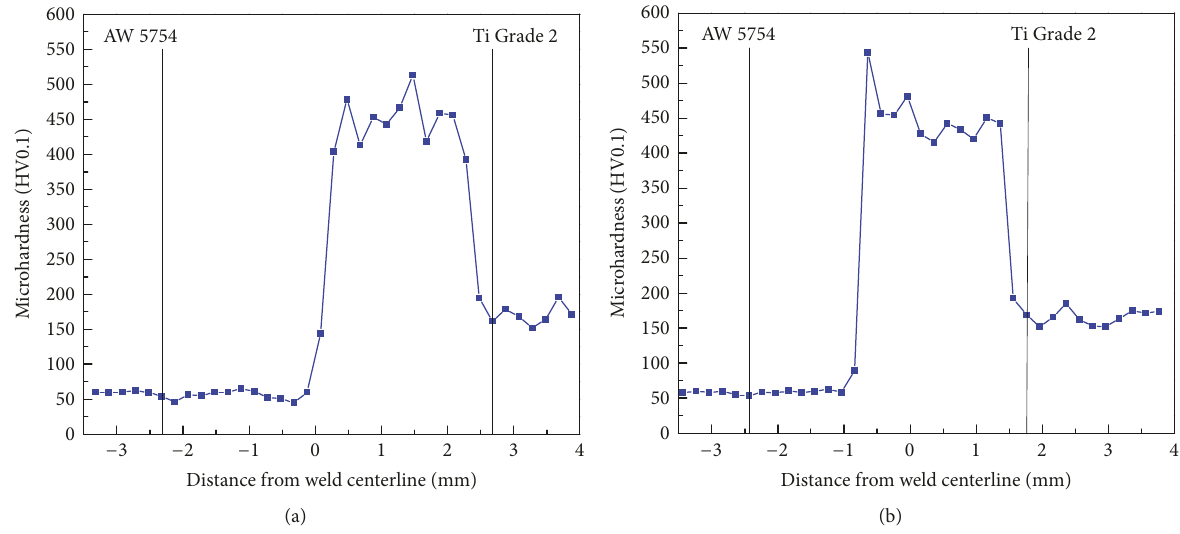
Figure 22: Results of microhardness measurements: the course of microhardness across AW 5754 aluminium alloy, weld metal, and titanium Grade 2 for (a) sample 3 and (b) sample 4.